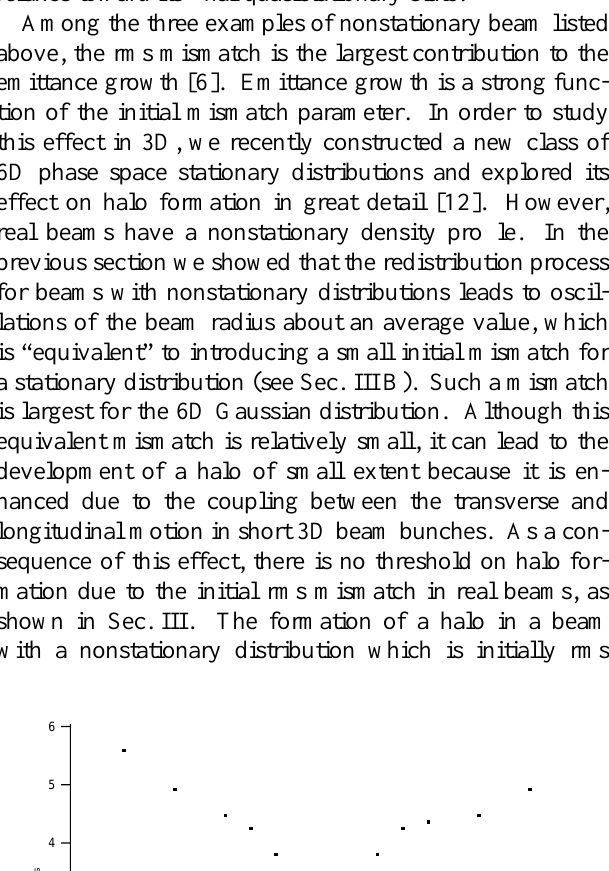
FIG. 14. Extent of the transverse halo for the 6D stationary distribution with zero longitudinal mismatch m (cid:122) (cid:173) (cid:49)(cid:46)(cid:48) ( (cid:99) (cid:121) (cid:97) (cid:173) (cid:51)(cid:44) h (cid:120) (cid:173) (cid:48)(cid:46)(cid:53)(cid:51)(cid:44) h (cid:122) (cid:173) (cid:48)(cid:46)(cid:51)(cid:57) ).